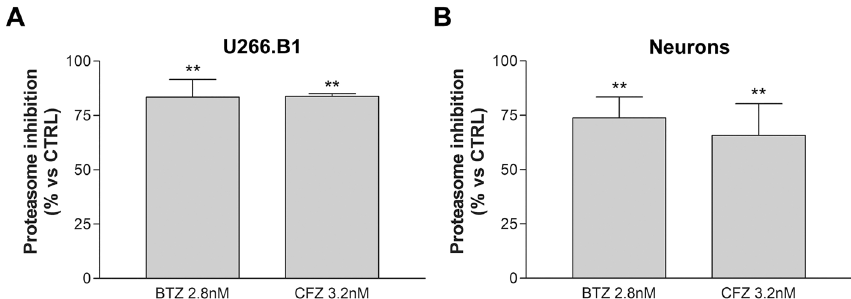
Figure 4. BTZ and CFZ induced proteasome inhibition in U266.B1 cells and sensory neurons. Proteasome inhibition of U266.B1 cells ( A ) and neurons ( B ) after treatment for 48 h with 2.8 nM BTZ or 3.2 nM CFZ. Graphs are represented as mean percentage ± SD compared to an untreated CTRL (arbitrarily set to 0%). ** p < 0.01 versus CTRL